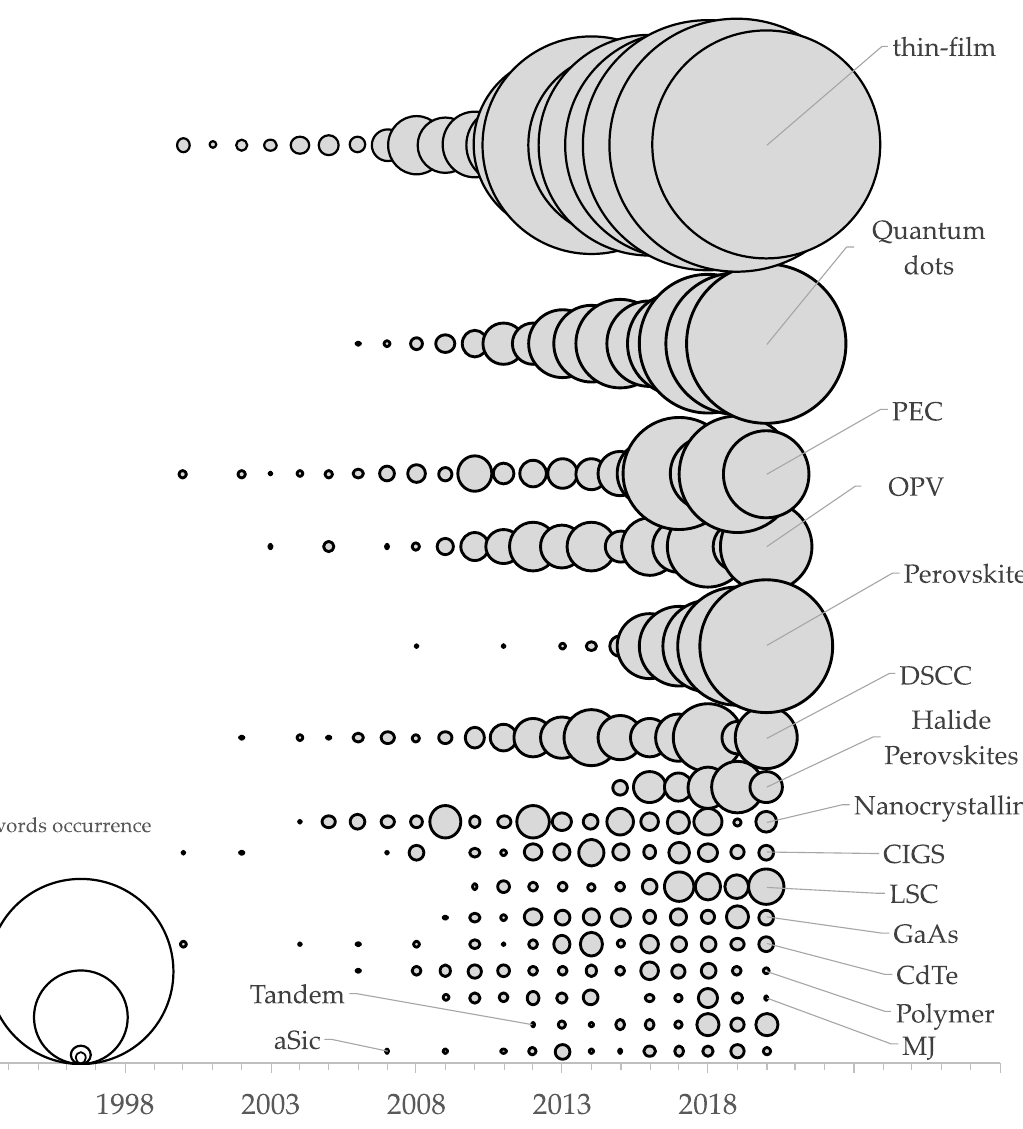
Figure 15. Evolution of 50 most common keywords of year 2020 within the period 1990–2020. Figure 15. Publishing evolution on solar cells